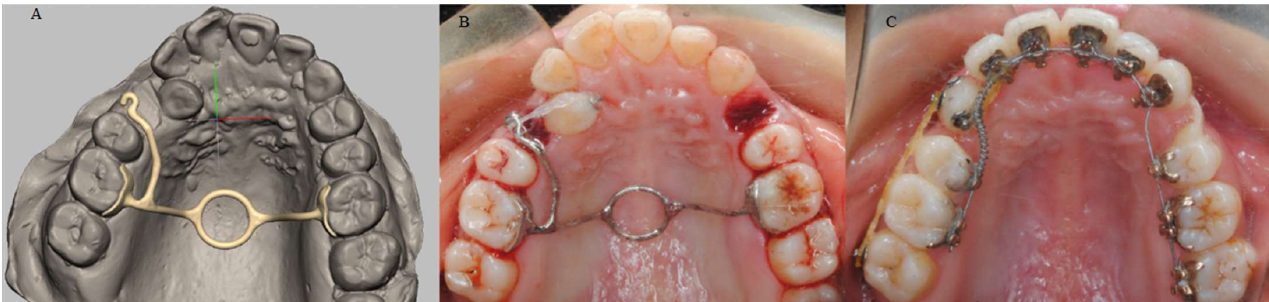
Figure 8. ( A ) A 3D TPA with a lateral arm, used to correct buccally flared second molar; ( B ) the buccally flared second molar corrected using the 3D TPA.